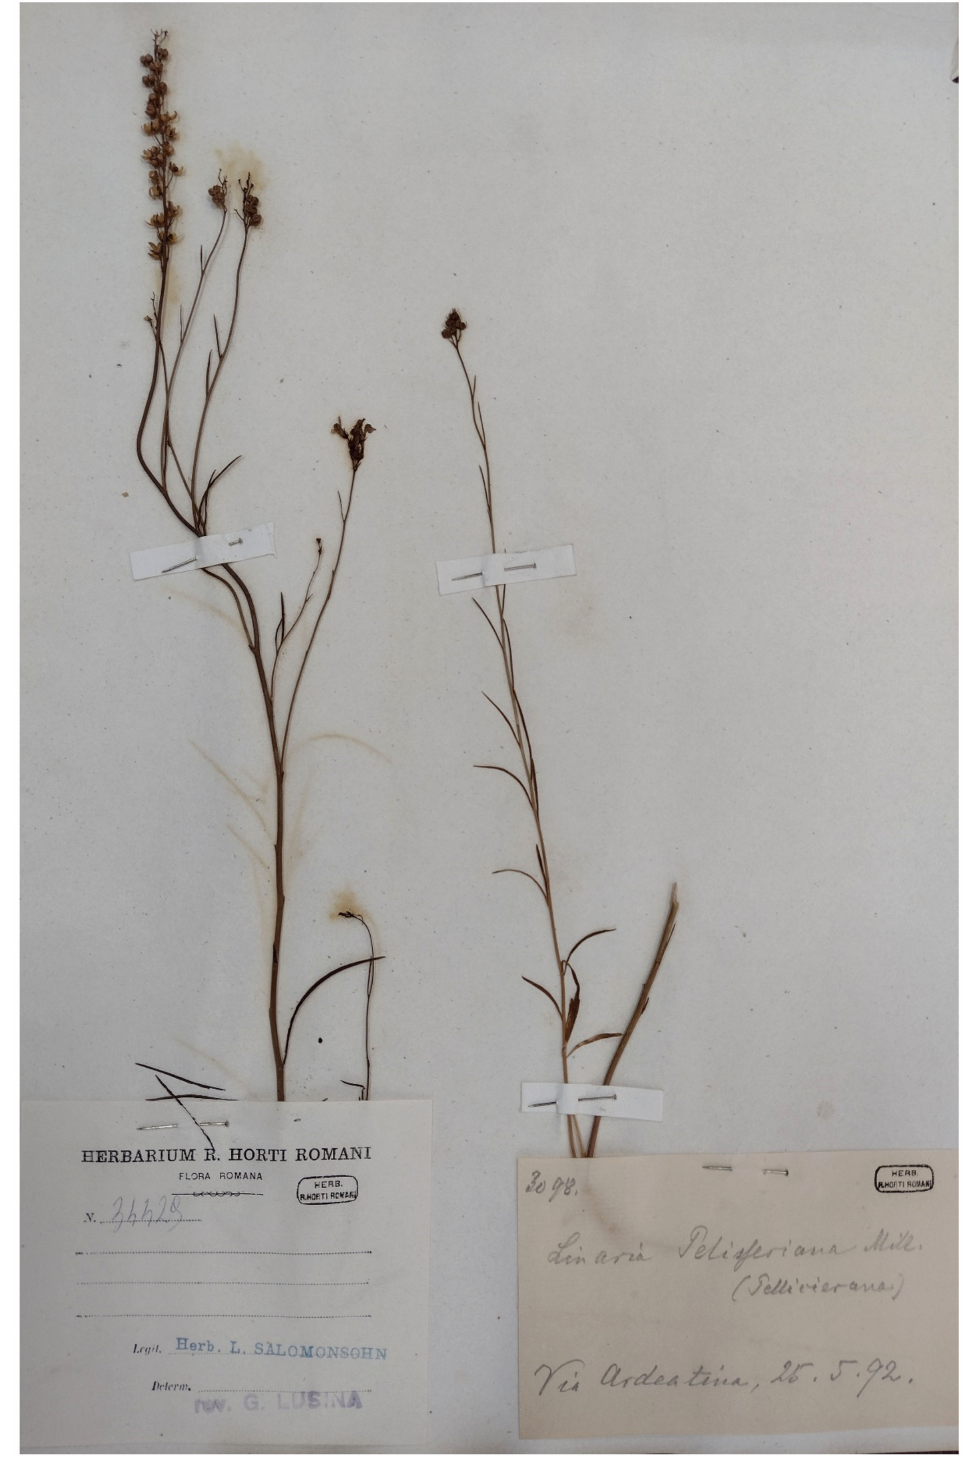
Figure 65. Specimen of Linaria pelisseriana collected along Ardeatina street on 15 May 1892 (RO- Herbarium Romano no.